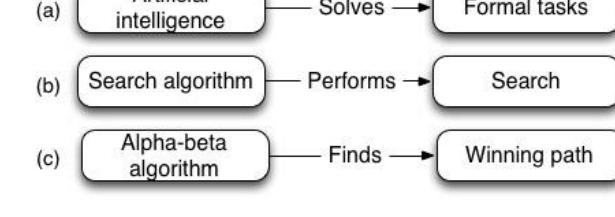
Fig. 3. Propositions used for